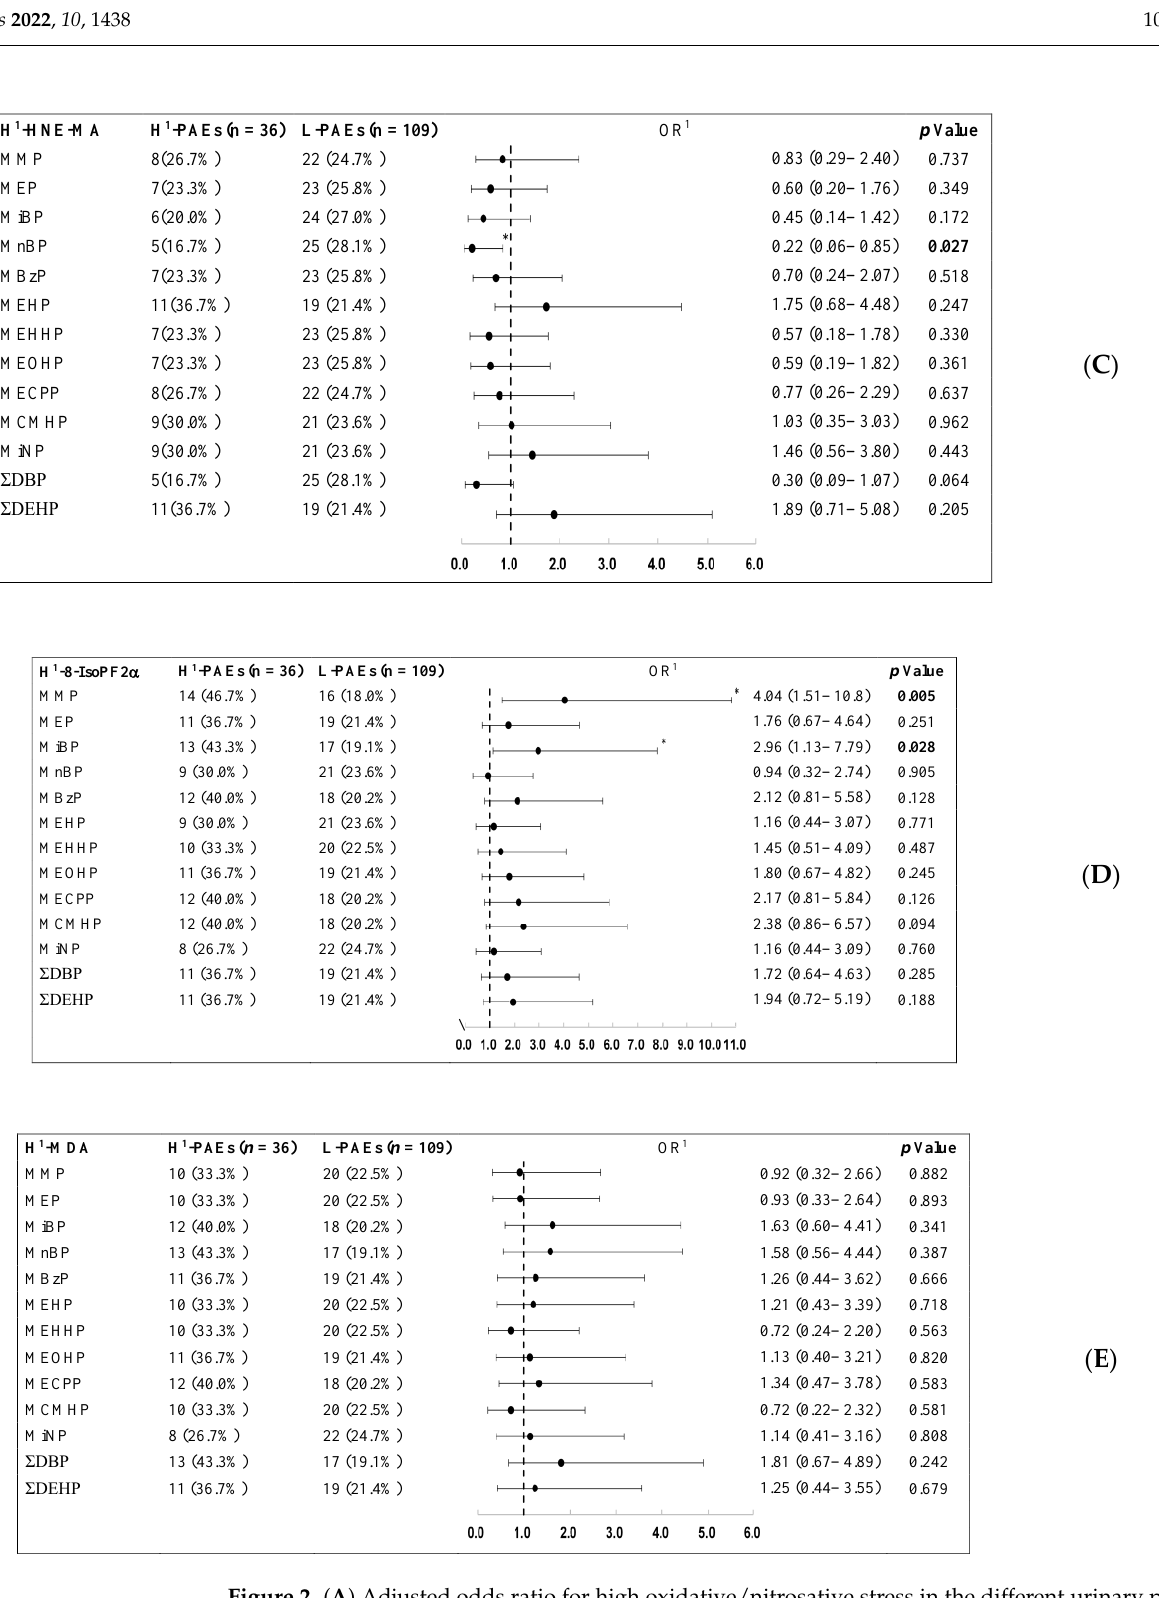
Figure 2. ( A ) Adjusted odds ratio for high oxidative/nitrosative stress in the different urinary phtha- late metabolite level groups. H 1 : 75th percentile of the 8-OHdG and urinary phthalate metabolite level. Model adjusted for creatinine, passive smoking during pregnancy, annual income, and raising a furry or feathery pet. ( B ) Adjusted odds ratio for high oxidative/nitrosative stress in different urinary phthalate metabolite level groups. H 1 : 75th percentile of the 8-NO 2 Gua and urinary phthalate metabolite level. Model adjusted for creatinine, passive smoking during pregnancy, annual income, and raising a furry or feathery pet. ( C ) Adjusted odds ratio for high oxidative/nitrosa- tive stress in different urinary phthalate metabolite level groups. H 1 : 75th percentile of the HNE-MA